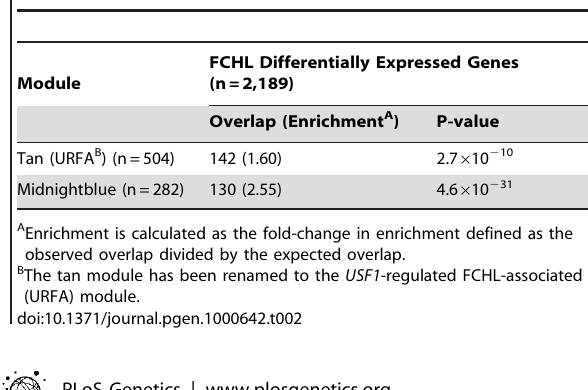
Table 2. Overlap of FCHL modules with FCHL differentially expressed gene list.